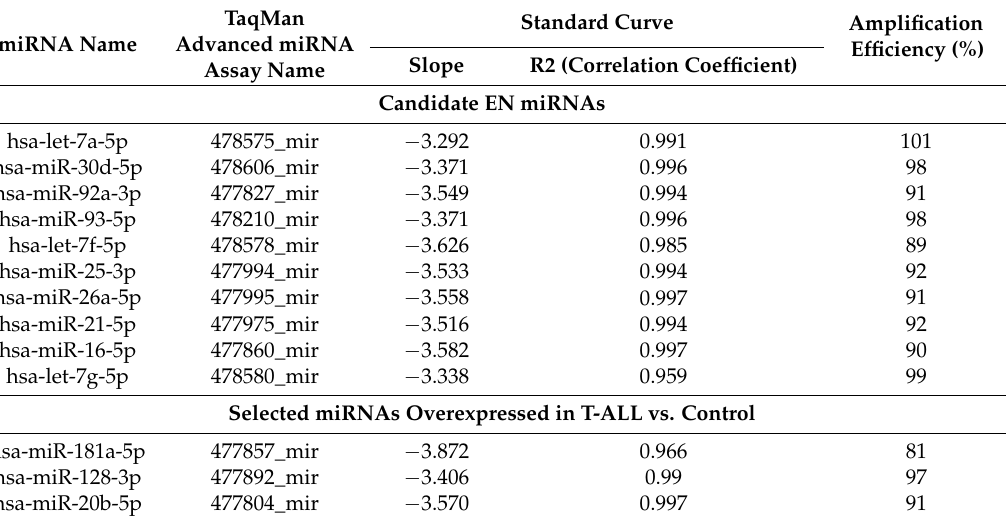
Table 2. Amplification efficiency of miRNA